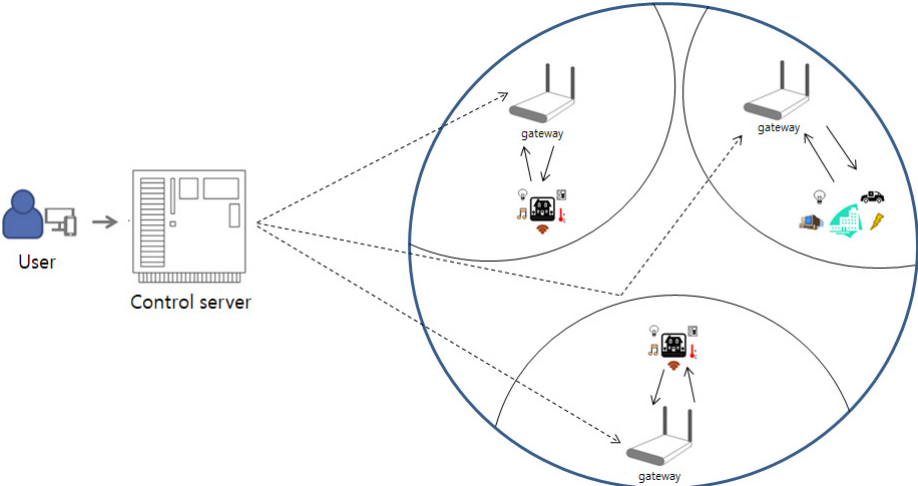
Figure 1. System model of our protocol in multi-gateway IoT environments.